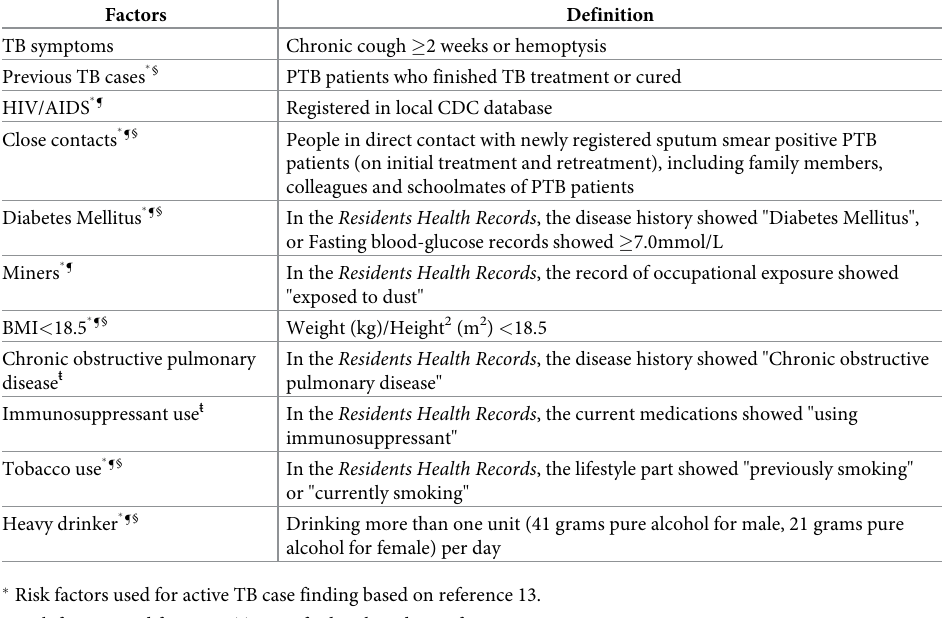
Table 1. Definition of TB symptoms and risk factors used for active TB case finding in Bayi Township, China from March–June